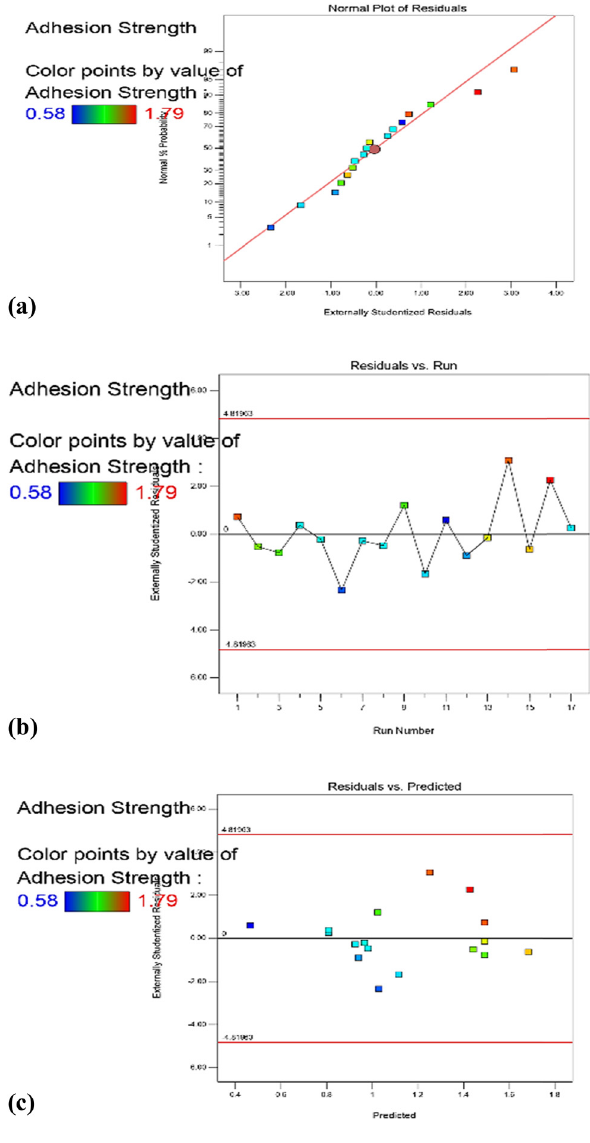
Figure 27: ( a ) Normalpercent probability graphforadhesionstrength. ( b ) Residual vs predicted graph for adhesion strength. ( c ) Residual vs run graph for adhesion